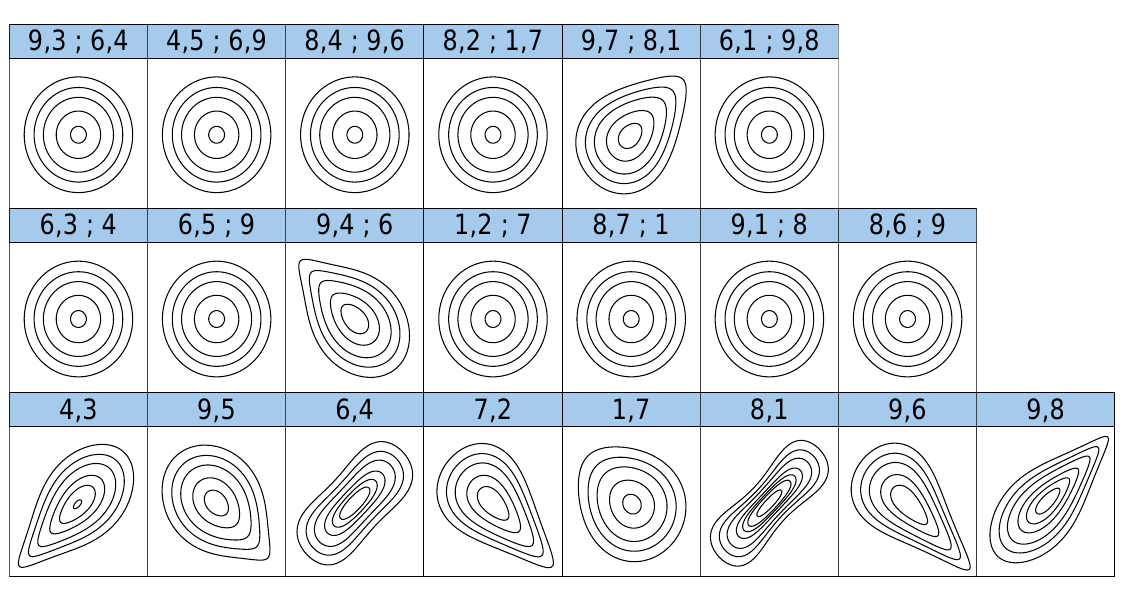
Figure 3. Normalized contour plots for trees 1, 2, and